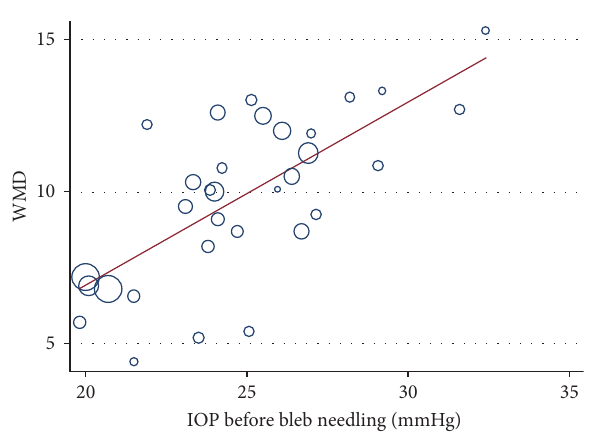
Figure 5: Metaregression for IOP before bleb needling: metare- gression revealed that IOP before bleb needling significantly contributed to the heterogeneity of WMD of IOP reduction at last visit ( p < 0 . 001 )